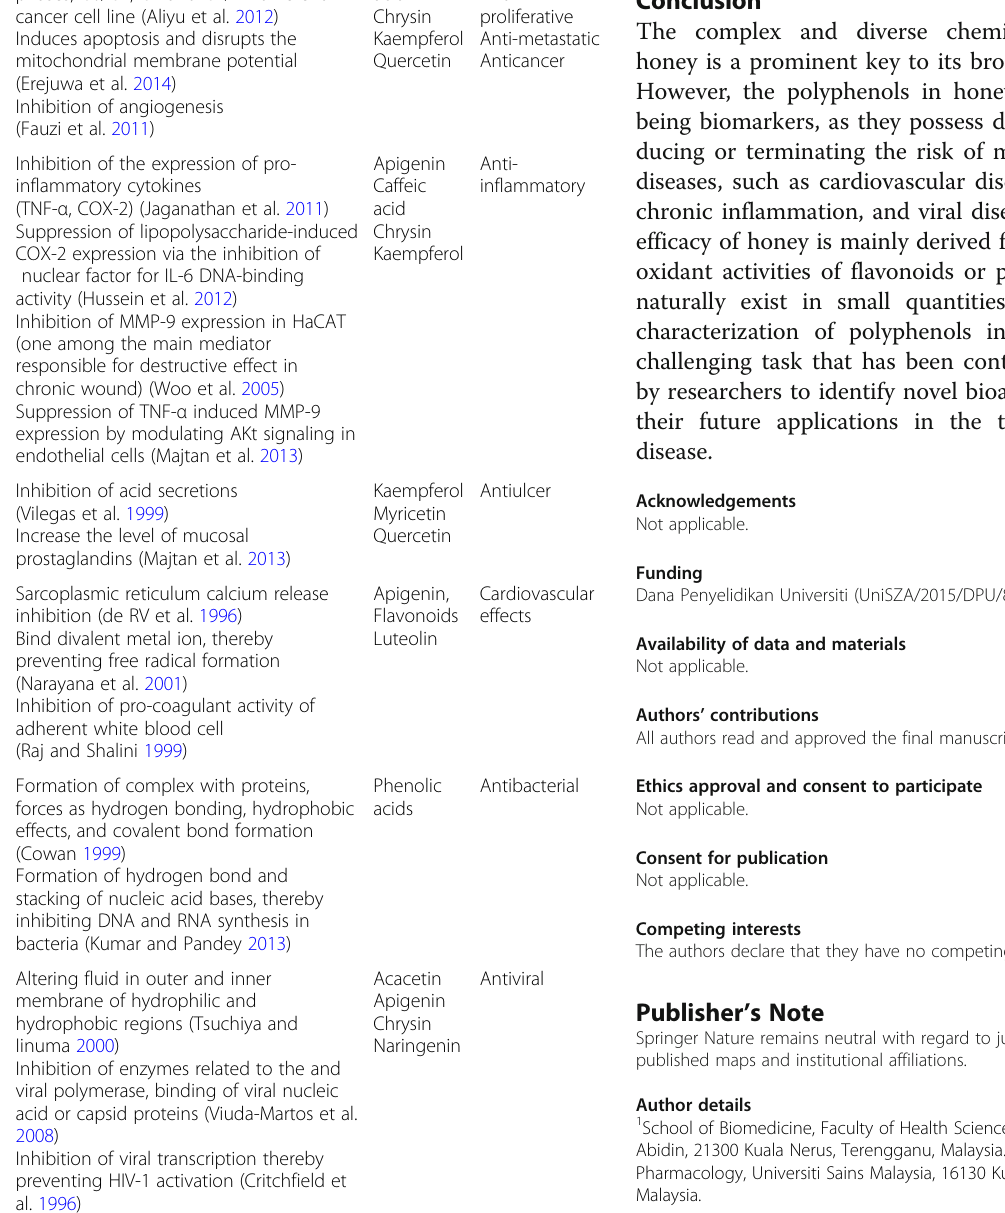
Antineoplastic Anti-